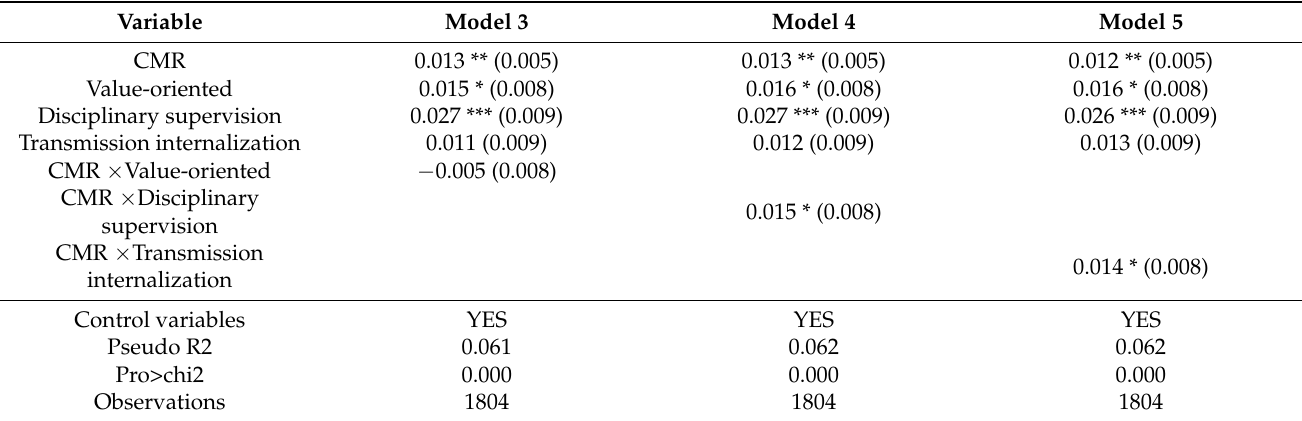
Table 6. Interaction effect